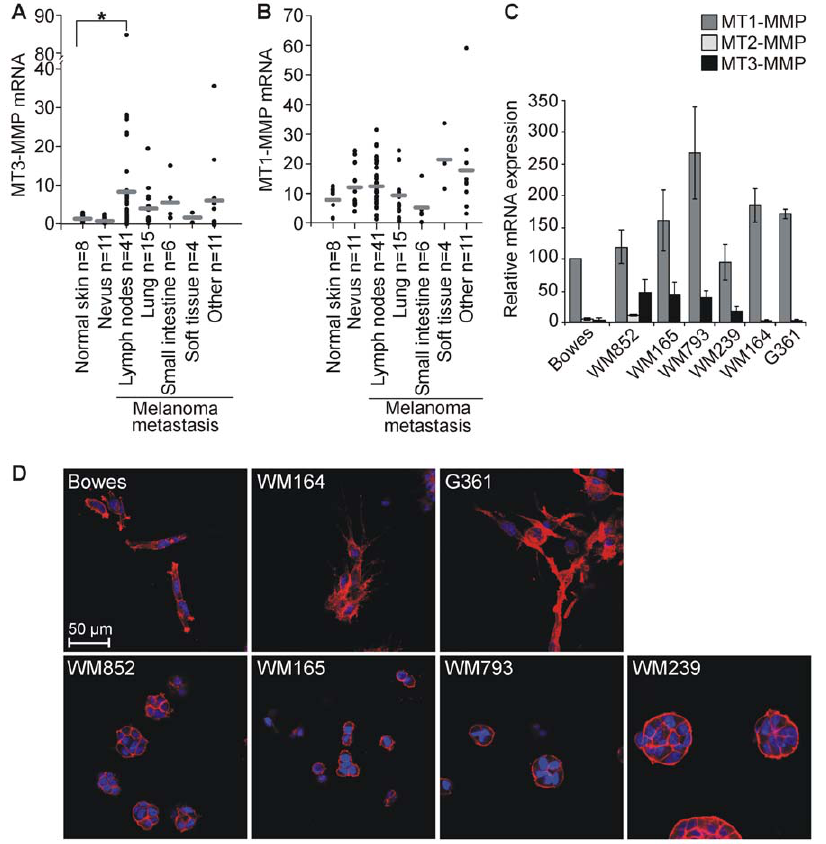
Figure 1. MT3-MMP is expressed in melanoma lymph node metastases and metastatic cell lines. MT3-MMP (A) and MT1-MMP (B) mRNA expression levels in human tissue biopsies from normal skin (n=8), nevus (n=11), and melanoma metastases (n=77) were assessed by qPCR. cDNAs were normalized against beta-actin. Soft tissue comprise metastases obtained from subcutaneous tissue of groin (n=2), pelvis (n=1) and thigh (n=1). Other organs comprise single or double biopsies from melanoma metastases to skin, stomach, liver, mediastinum, ovary, kidney and brain. *p=0.028 (p=0.031 if the highest outlying lymph node metastasis value of 84.4 is excluded). (C) Relative values of average MT1-, MT2- and MT3-MMP mRNA expression were analyzed by qPCR in 7 melanoma cell lines as indicated. (D) The melanoma cells were embedded inside 3D collagen type I gels. After 4-d culture, the 3D cell/matrix constructs were fixed and stained with TRITC-phalloidin (red) and DAPI (blue). Fluorescence micrographs of the collagen gels show representative cell